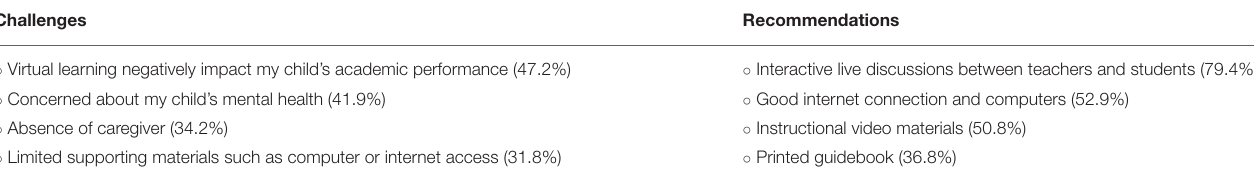
TABLE 4 | Respondents’ reported challenges and recommendations in implementing virtual learning ( n = 17,562). Challenges